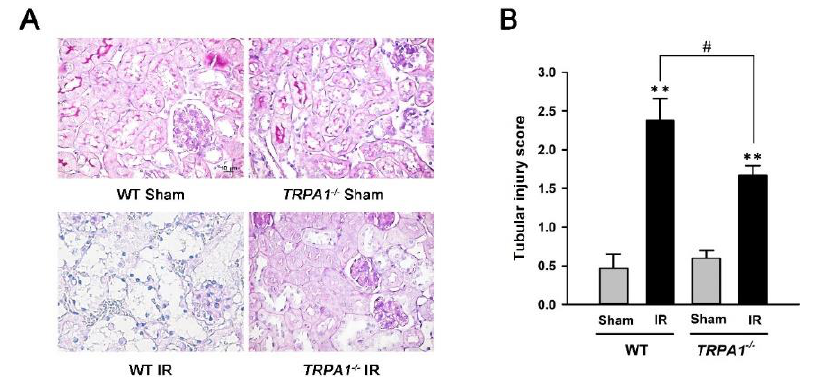
Figure 3. Renal tubular injury induced by IR is less in trpa1 -/- mice. ( A ) Representative images of periodic acid-Schiff (PAS) staining in renal sections obtained from the two genotypes of mice subjected to two different treatments. The magnification of each panel was 400 × . ( B ) Tubular injury score was calculated according to the percentage of injured area of tubular cross sections. The scores system is described in the methods. Data in each group are mean ± SEM from 6 mice. ** p < 0.01 versus the sham group in each genotype; # p < 0.05 versus the IR group of WT mice.